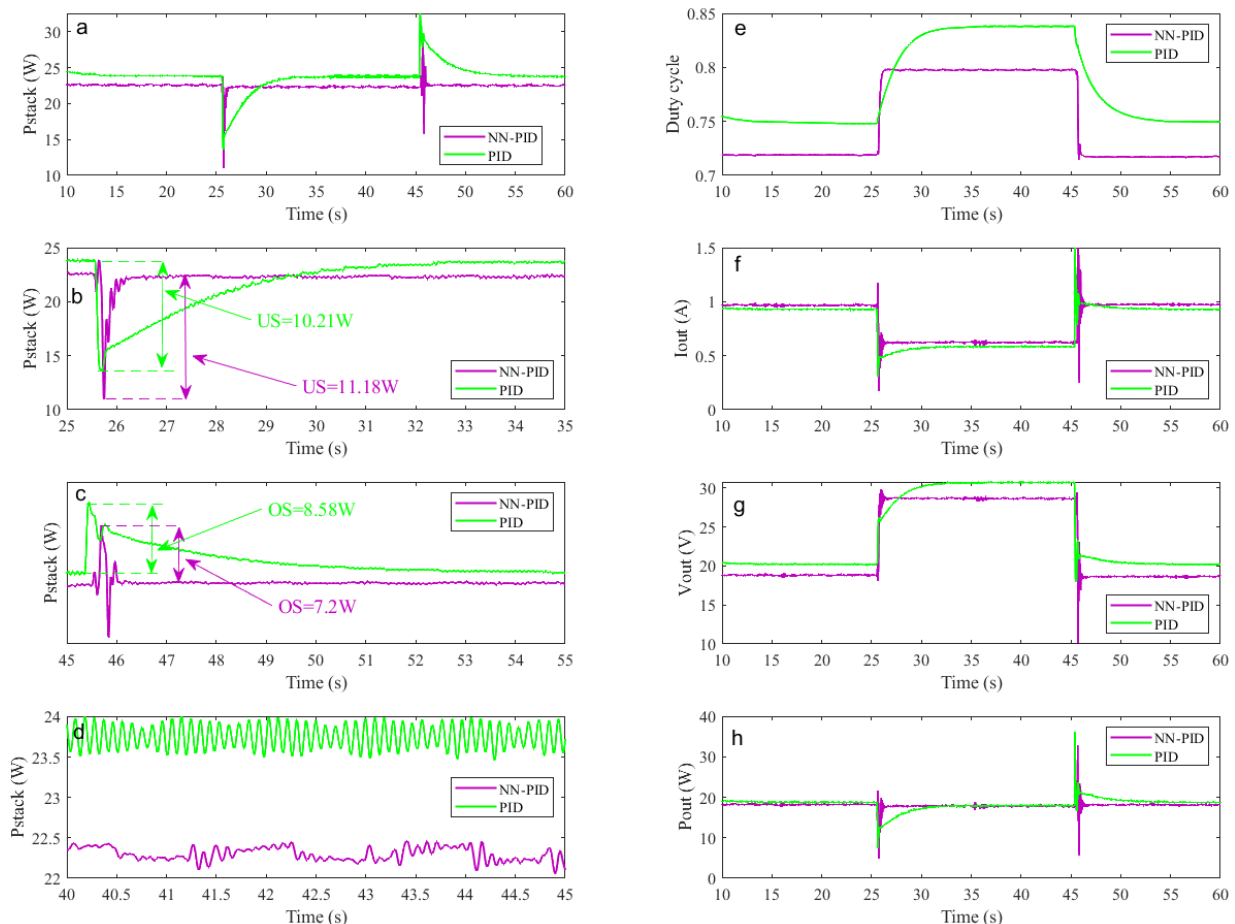
Figure 13. PID and NN-PID experimental results; ( a – d ): PEMFC stack power signal; ( e ): Duty cycle signal ( f ): Boost converter output current; ( g ): Boost converter output voltage; ( h ): Boost converter output power.